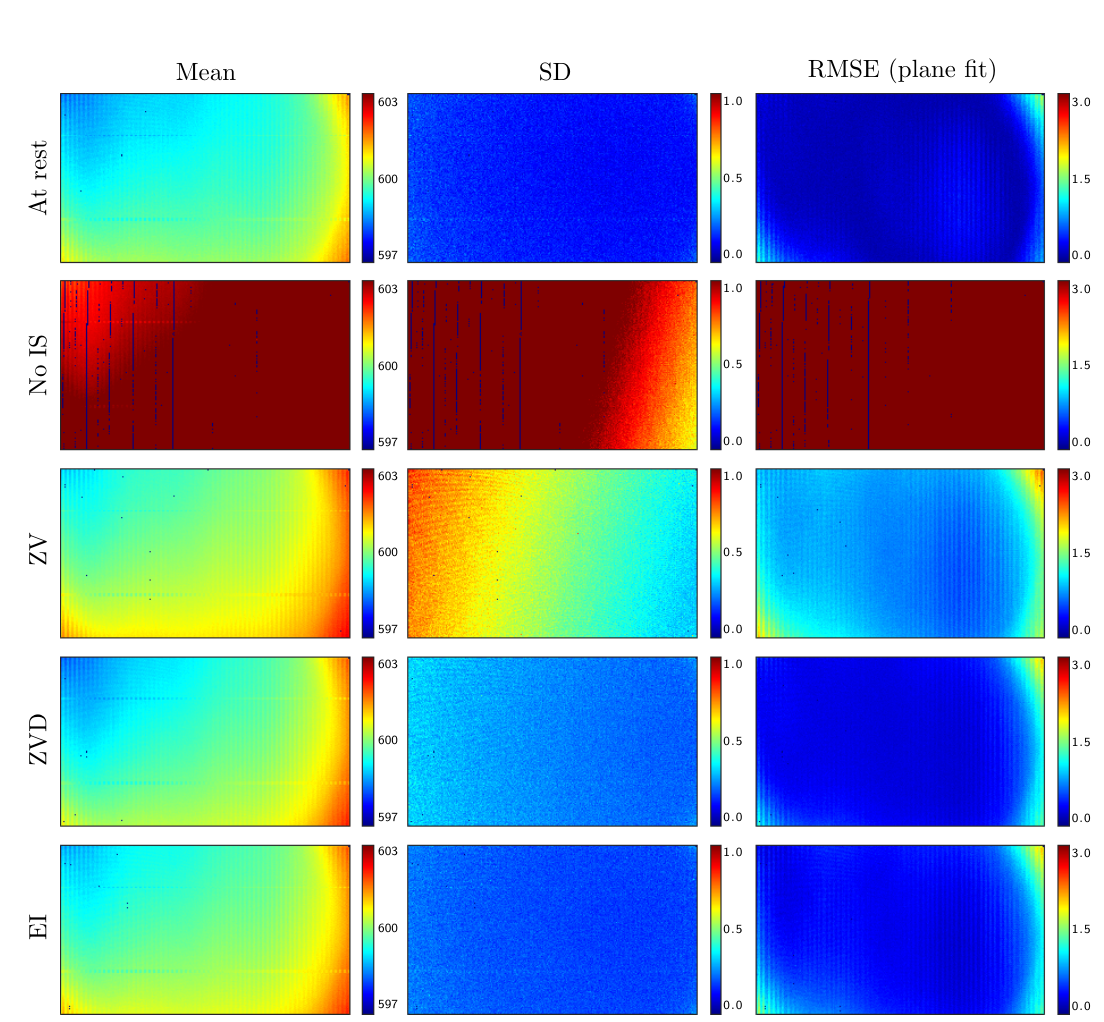
Figure 10: Statistics of 50 frames acquiring a planar surface (values in mm): Mean (left col.), standard deviation (middle col.), and RMSE with respect to a plane fitted using RANSAC (right col.). The 1st row is the raw range data captured with the robot at rest, and the 2nd row was captured when the robot executed the original, unshaped trajectory. For the 3rd row, the ZV shaper was used, the 4th row the ZVD shaper, and for the 5th, the EI